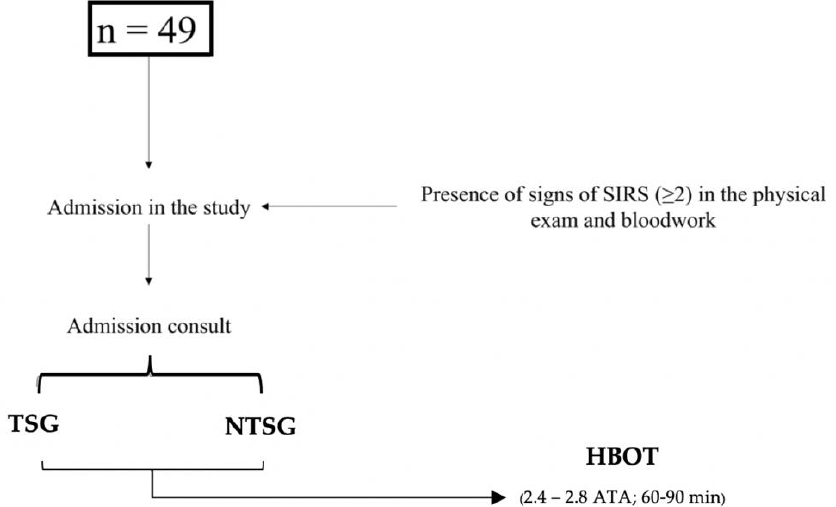
Figure 1. Diagram used for the admission of dogs in the clinical study. TSG, Traumatic Study Group; NTSG, Non-Traumatic Study Group; HBOT, Hyperbaric Oxygen Therapy. Table 3. Sample population characterization.